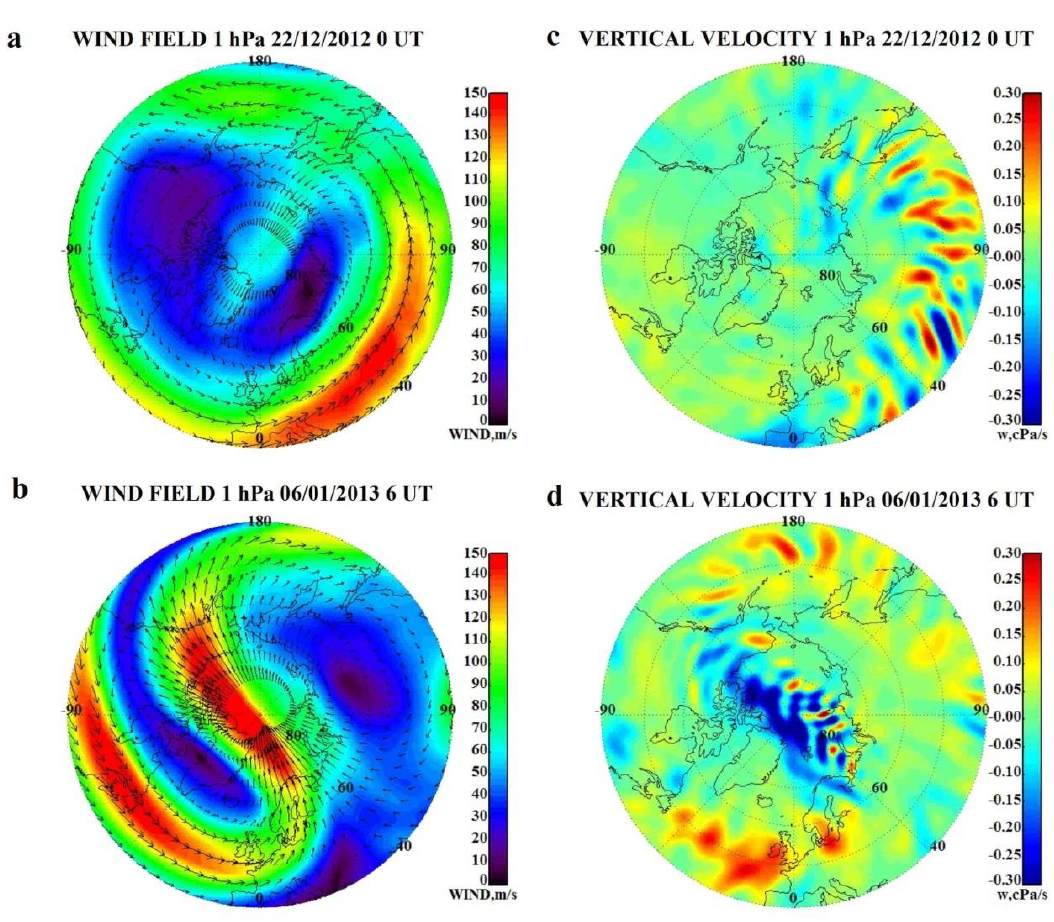
Figure 3. Horizontal wind field ( a , b ) and the atmospheric gas vertical velocity (c, d) at 1 hPa on 2012 December 22 ( a , c ) and on 2013 January 6 ( b , d ). Arrows on panels ( a , b ) show the direction of the air mass travel.